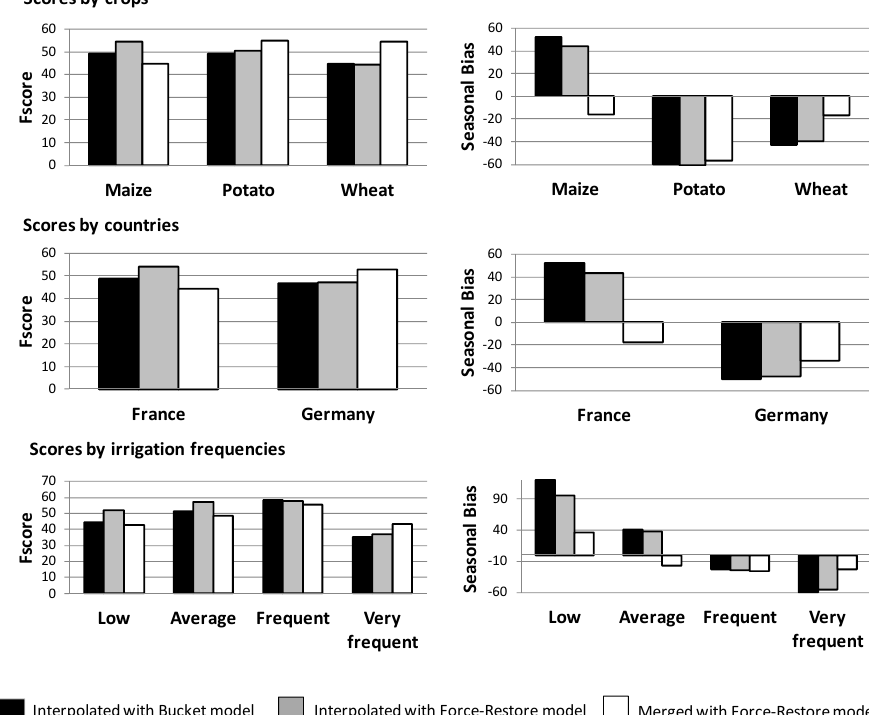
Figure 10. Comparison of the interpolated method with all data and the original SSM model, the interpolated method with all data and the force-restore model, and the merged runs with the force restore. On the left side, the histograms show the F-scores. On the right side, the histograms show the seasonal biases. From top to bottom, the results are shown for crops, countries, and irrigation frequencies.